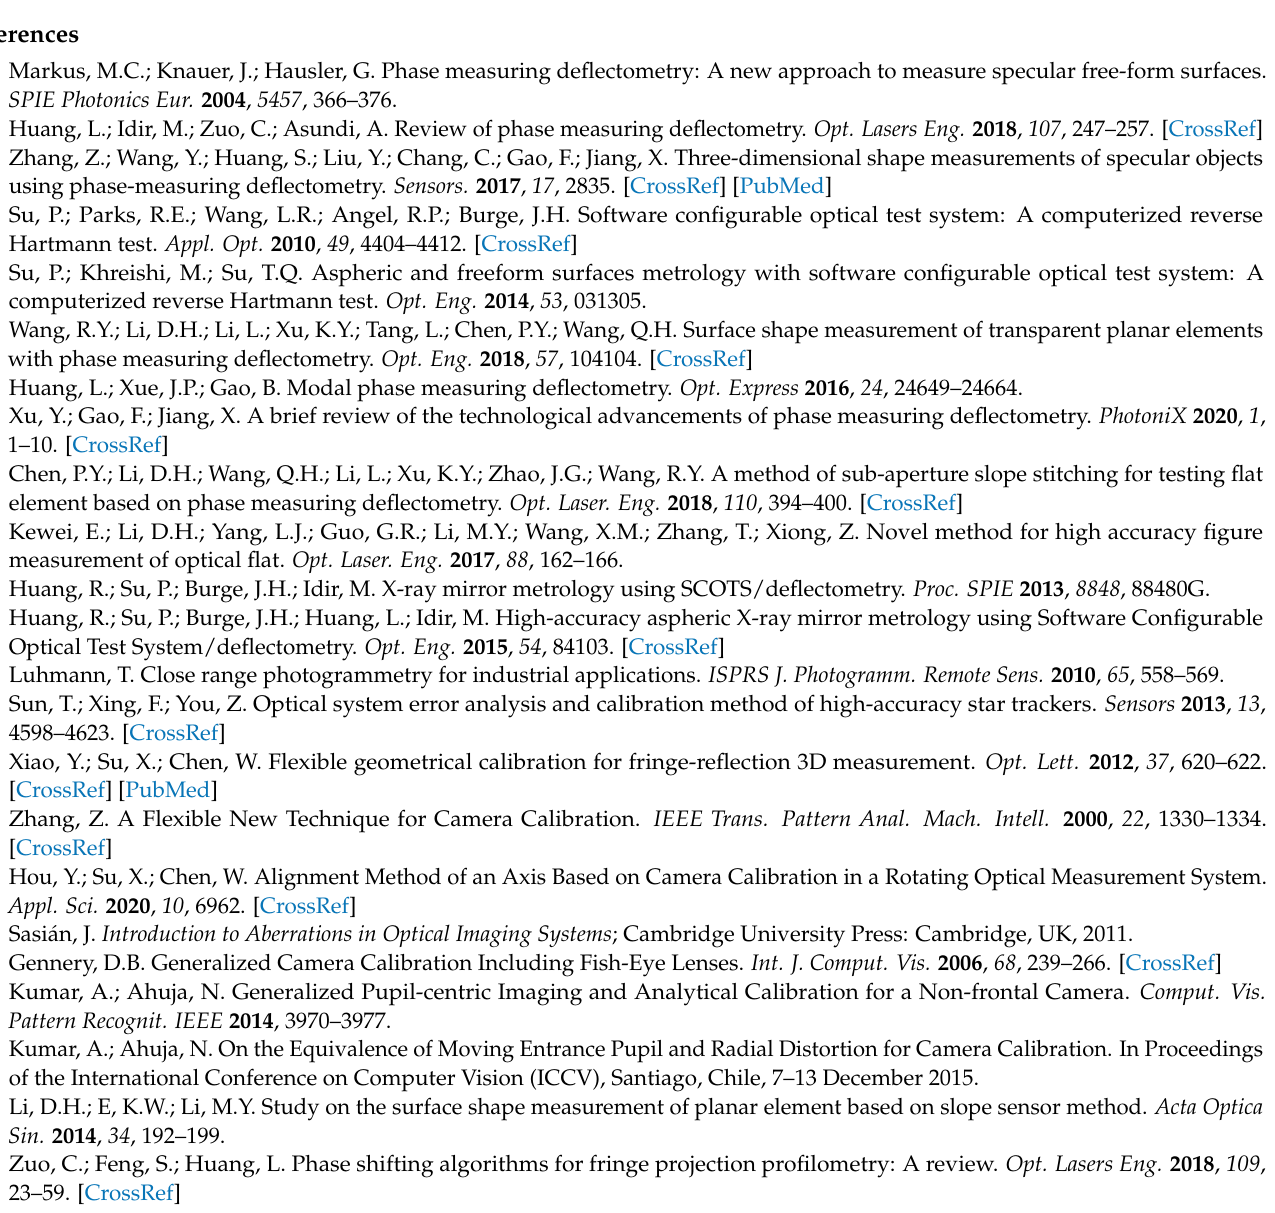
Figure A2. ( a ) Reconstruction results obtained by using our method. ( b ) Reconstruction results obtained by the interferometer.